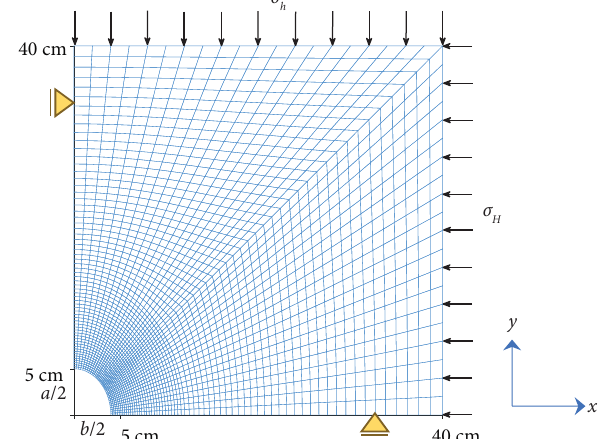
Figure 4: Problem domain, meshing, and boundary conditions.